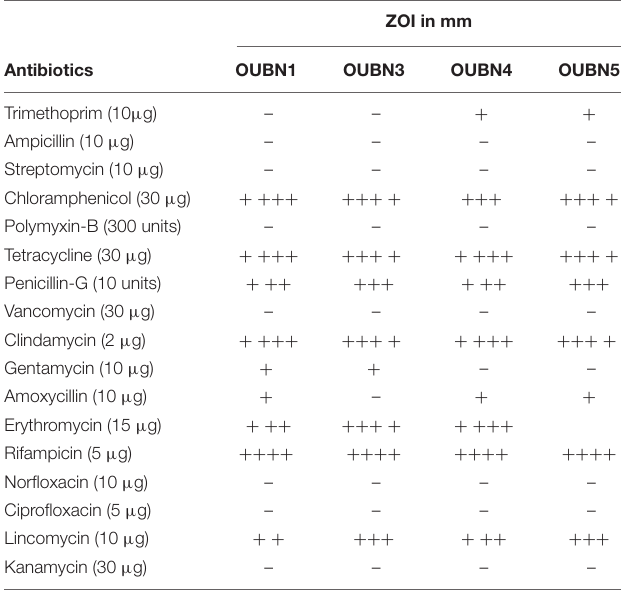
Rifampicin (5 µ g)